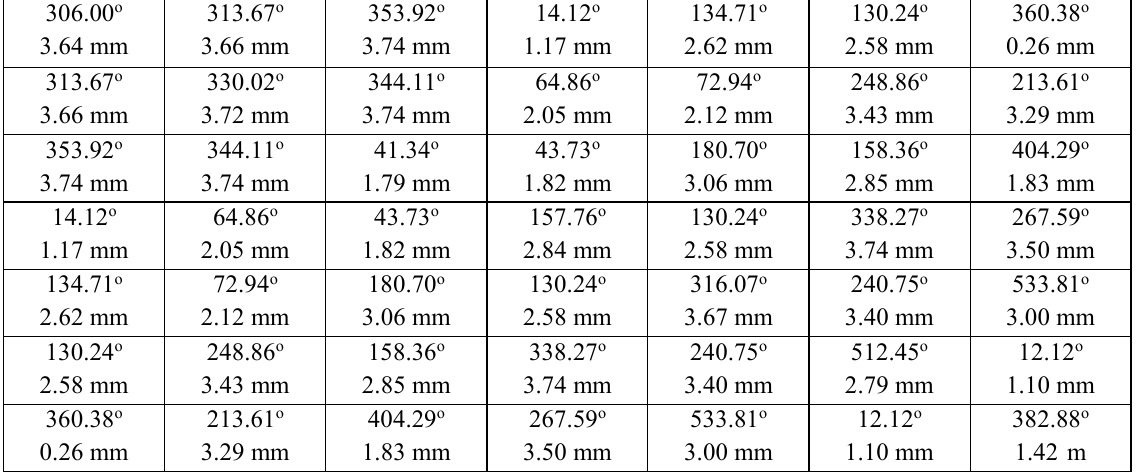
Table 2: The phase shift and the corresponding hole radius for FF/NF transmitarray (first quadrant). 306.00 o